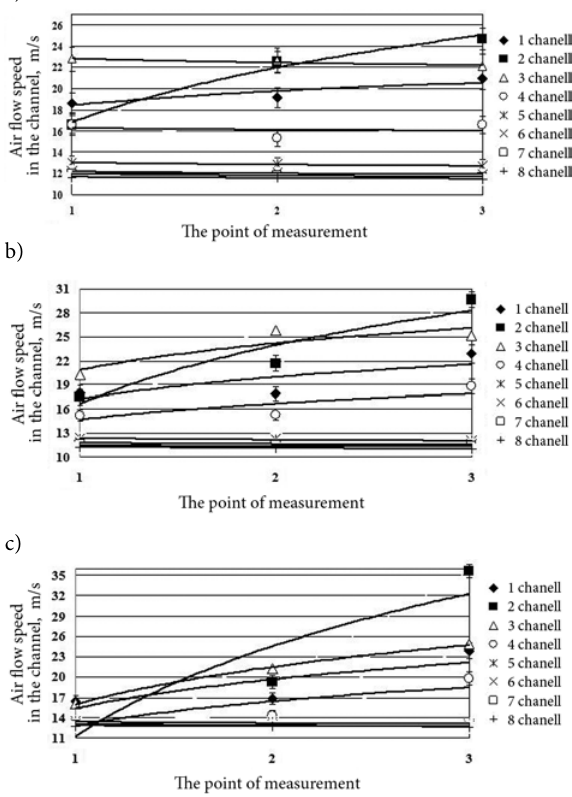
Fig. 6. Distribution of airflow velocities in 8-channel cyclone’s channels when quarter-rings with 5° opening angle of plates in holes are used: a) peripheral airflow volume is by 50% smaller than transit airflow volume (25/75); b) peripheral airflow volume is equal to transit airflow volume (50/50